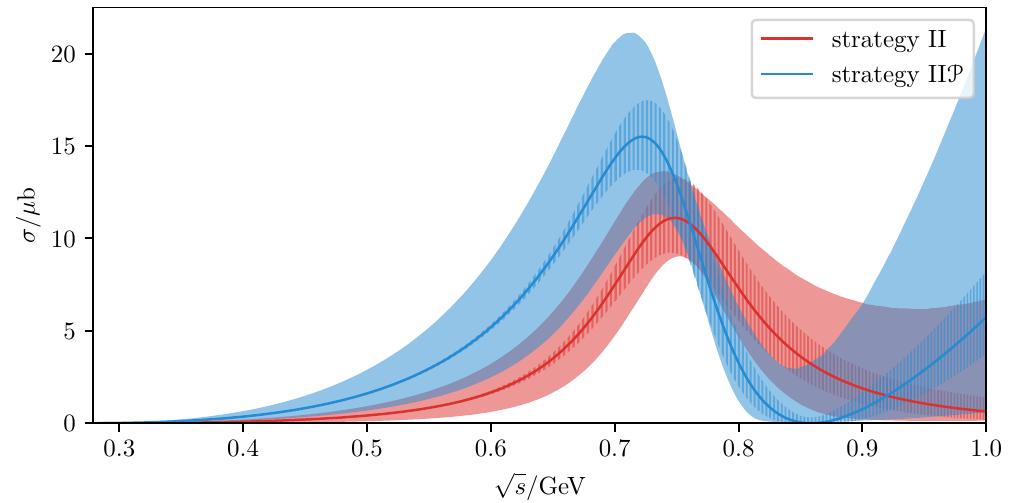
Figure 5. The cross section at the physical point for two different fit strategies. The error bands are as in figure